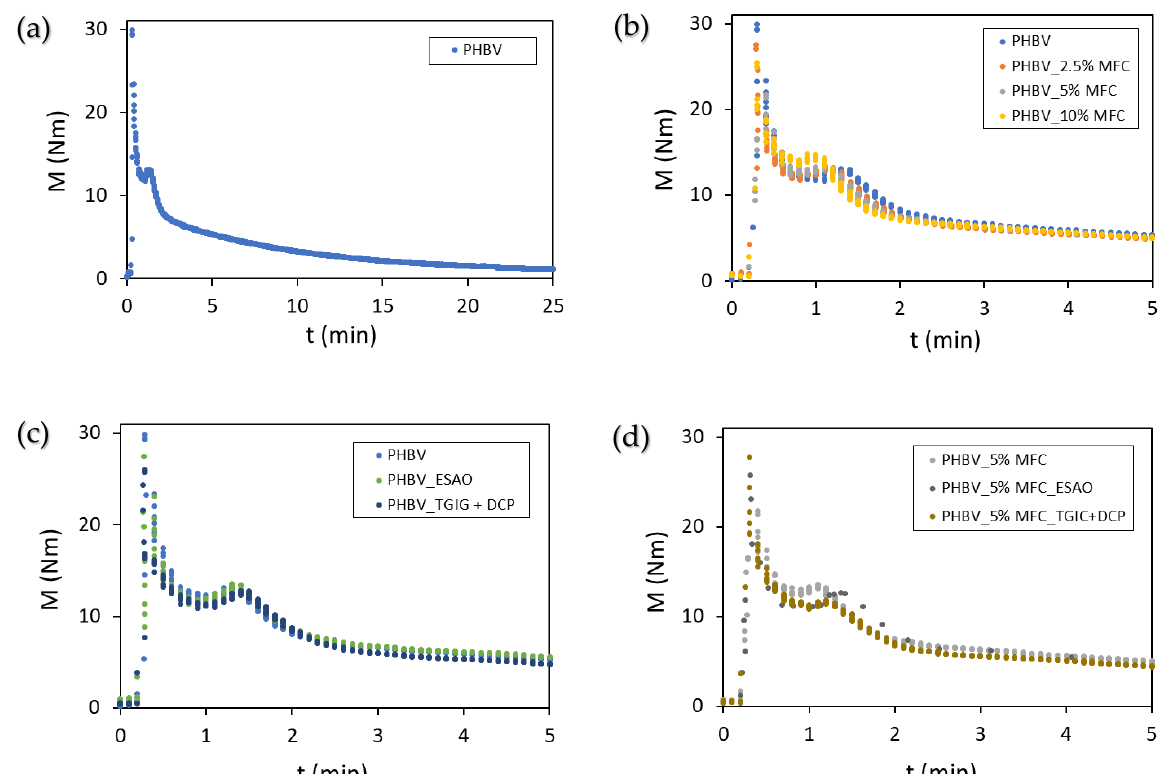
Figure 4. Representation of torque (M) as a function of time during melt mixing of the following: ( a ) poly(3-hydroxybutyrate- co -3-hydroxyvalerate) (PHBV) for 25 min; ( b ) PHBV without and with microfibrillated cellulose (MFC) at 2.5, 5, and 10 wt % for 5 min; ( c ) PHBV without and with epoxy-based styrene-acrylic oligomer (ESAO) and with triglycidyl isocyanurate (TGIC) and dicumyl peroxide (DCP) for 5 min; ( d ) PHBV/MFC at 5 wt % without and with ESAO and with TGIC and DCP for 5 min.